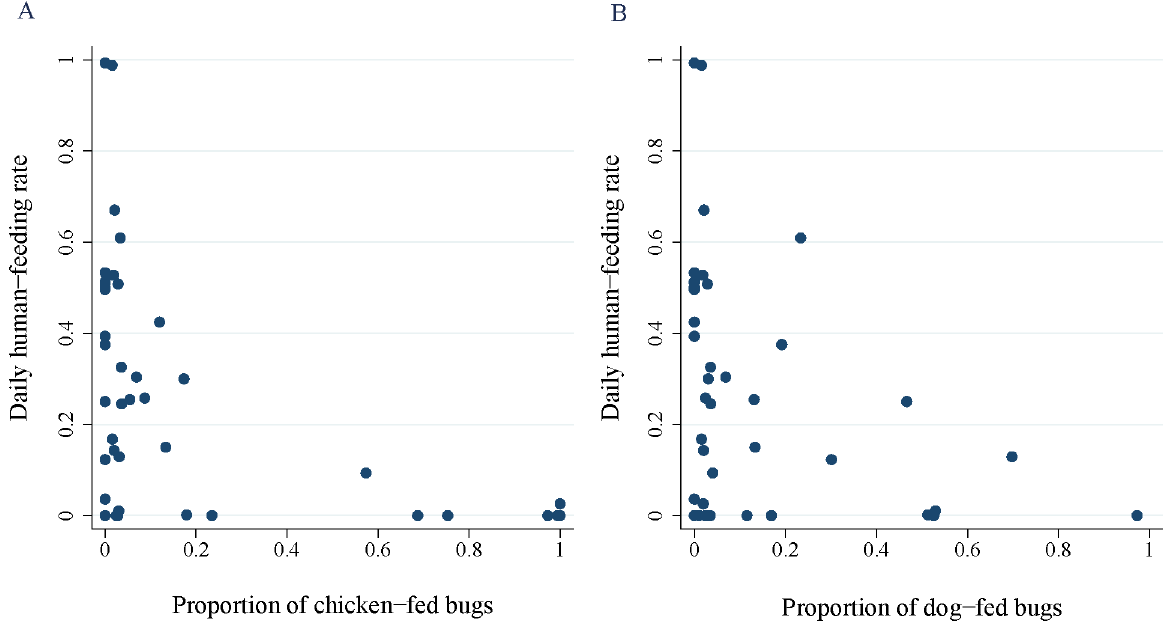
Figure 4. Daily human-feeding rate of late-stage domestic T.infestans according to the proportion of chicken-fed bugs (A) and dog- fed bugs (B). The daily human-feeding rate is the proportion of bugs that fed on humans only on the previous night. Figueroa, October 2003 (spring). Each data point corresponds to a different house. doi:10.1371/journal.pntd.0002894.g004 PLOS Neglected Tropical Diseases |